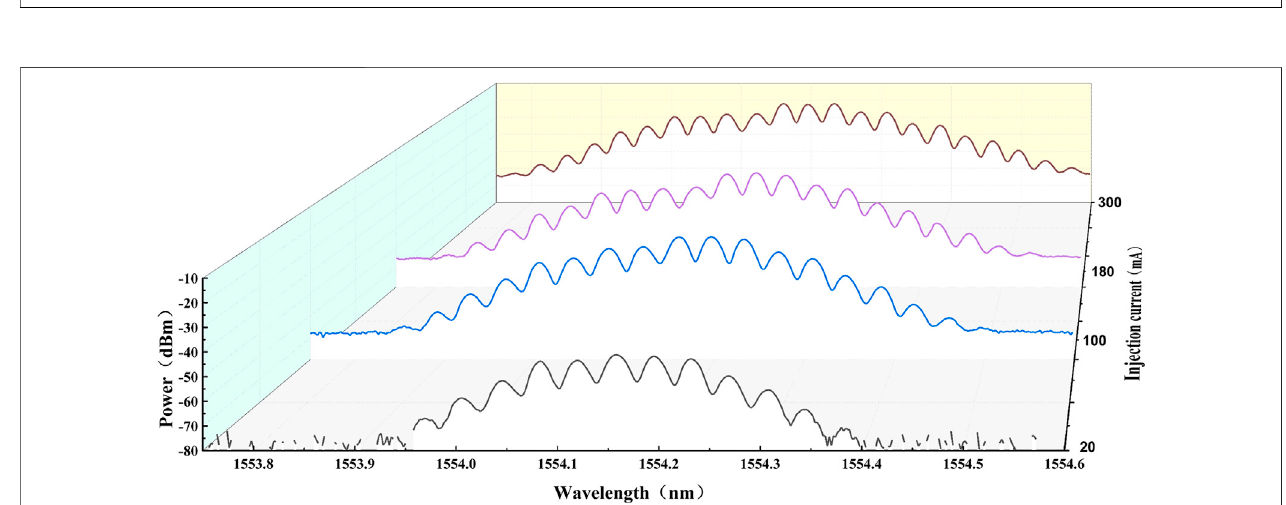
FIGURE 6 | Experimentally obtained FWM-broadened OFCs under different injection currents of the SOA.